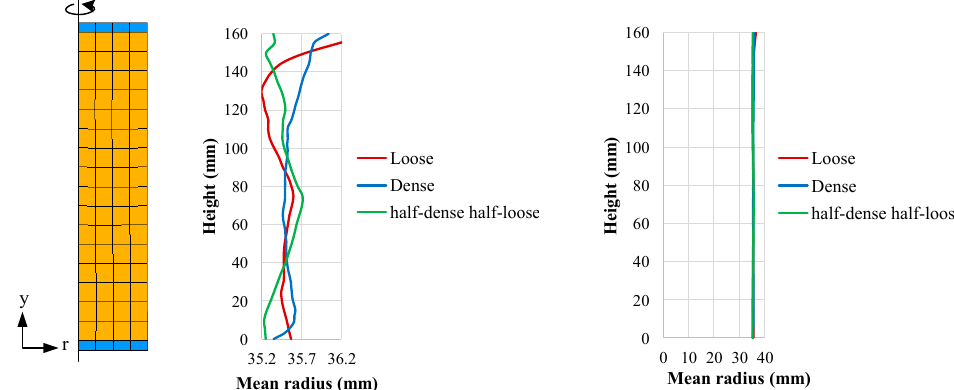
Figure 8. Vertical profiles of each of the three specimens analyzed (notice that the mean radius figures are the same observations but plotted at different scales).